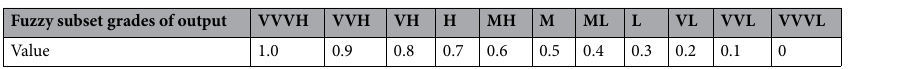
Table 14. The values and the fuzzy subset grades of output.